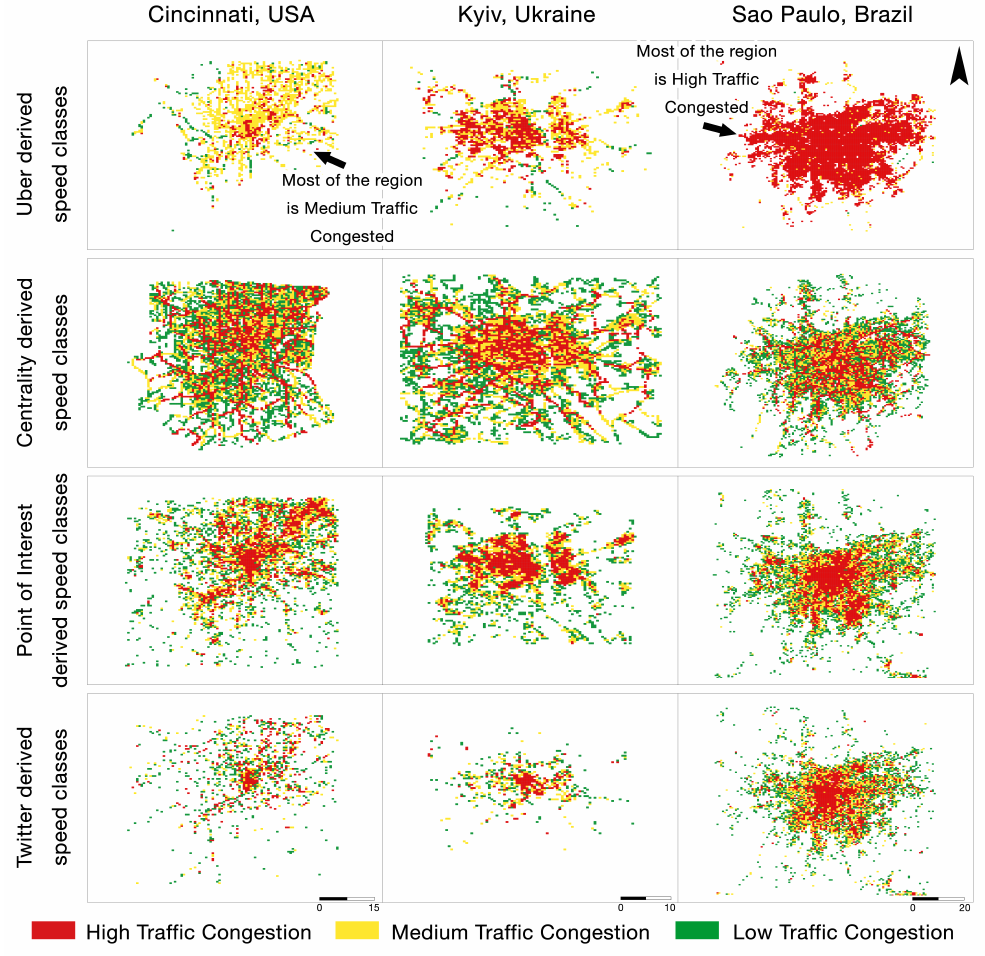
Figure 7. Visualising traffic congestion classes derived from all feature spaces using a quantile approach and validation (Uber) dataset for three cities (showing both edge case scenarios). The number of cells with predictions differs, as the predictors were not available for all tiles. The precision of the model predictions is presented in Figure